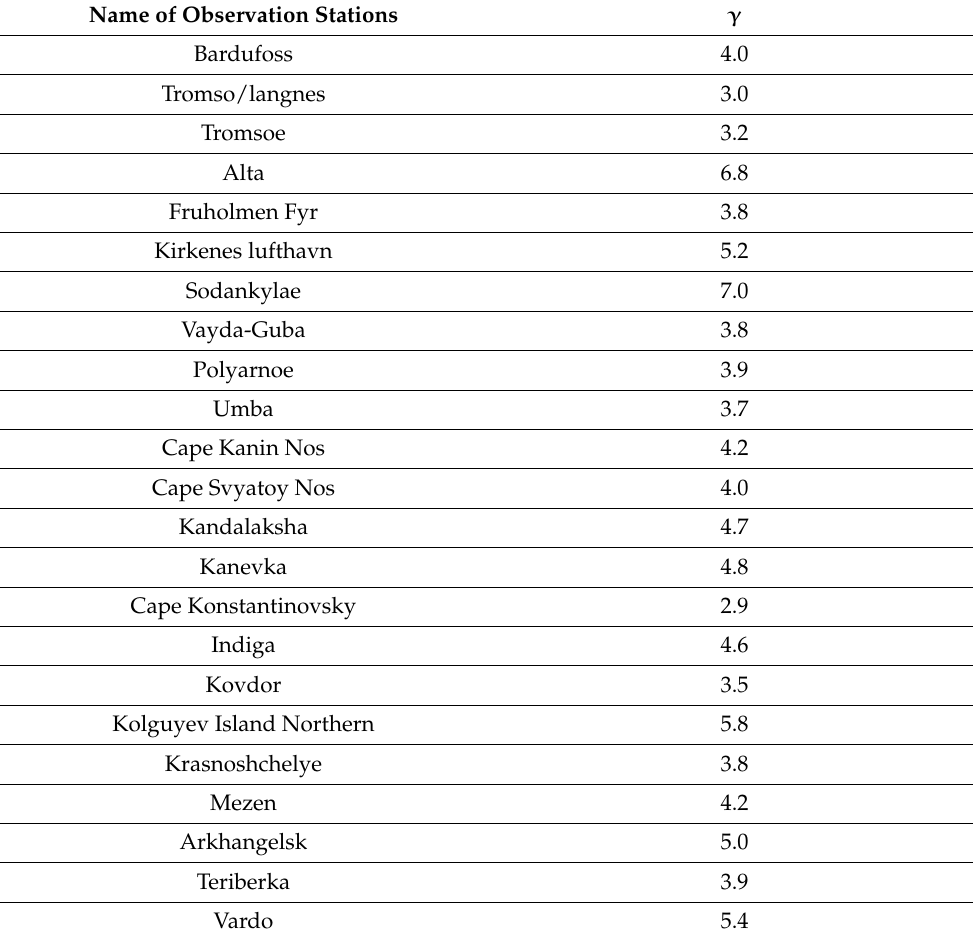
Table 1. The Pareto distribution parameter γ calculated for each station. Name of Observation